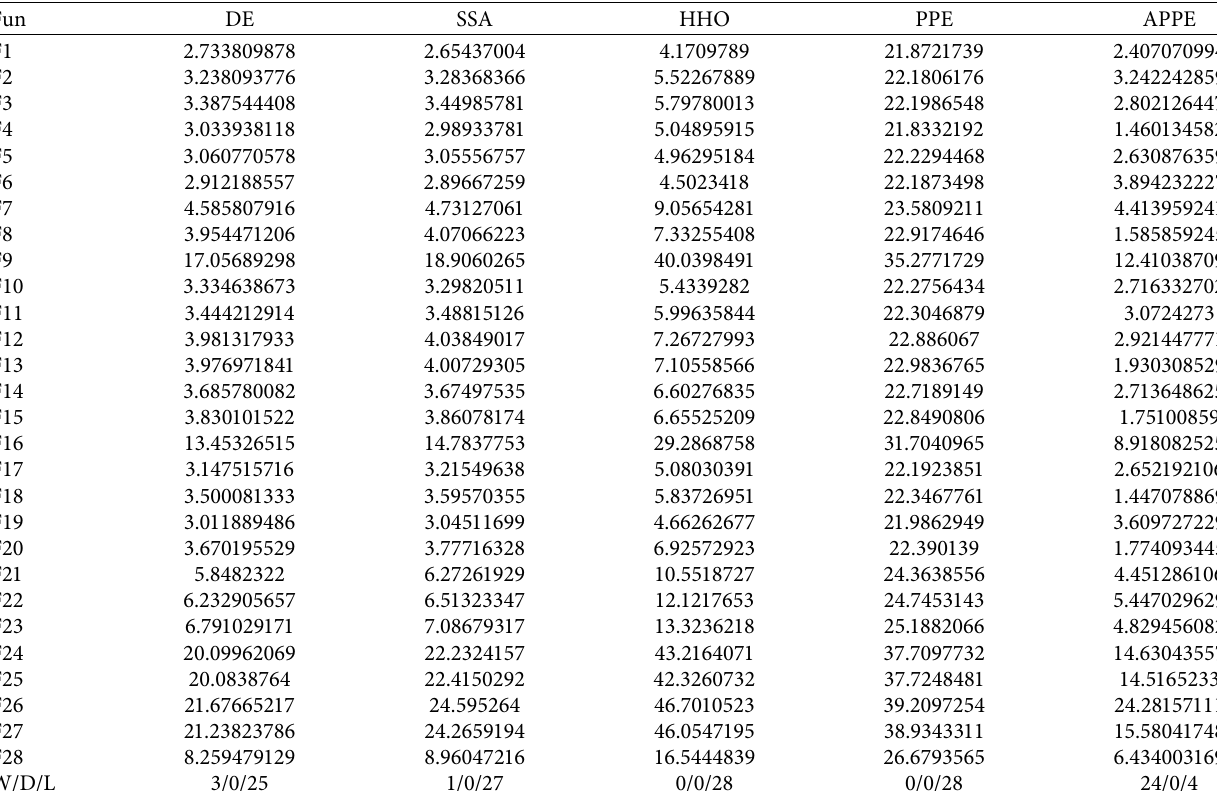
Table 9: Comparison of the average running time result of 51 runs on 30D in 28 benchmark